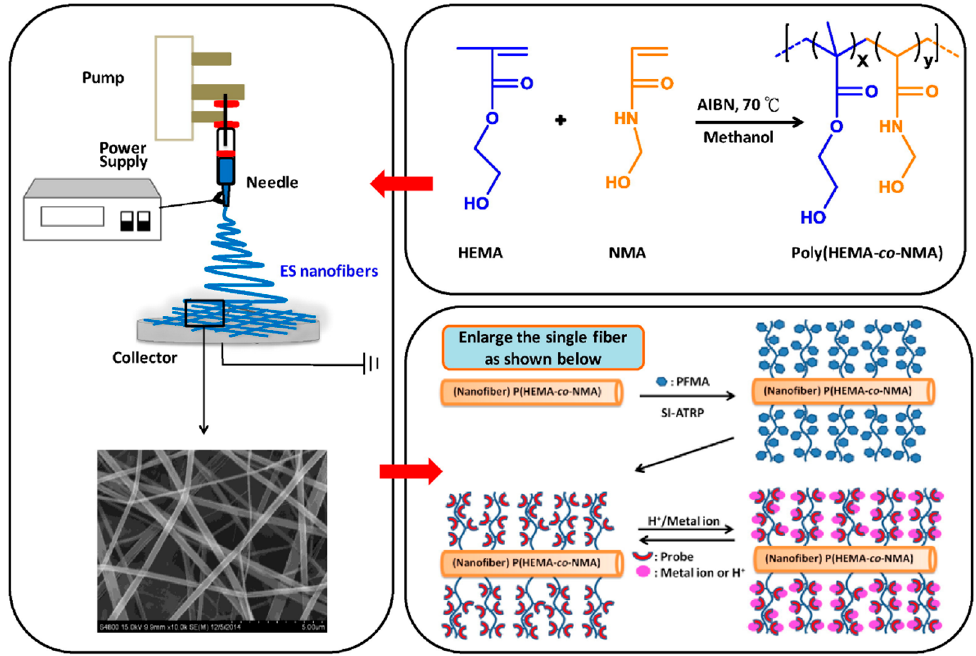
Figure 8. Design of multifunctional fluorescent ES nanofibers from poly(HEMA- co -NMA) ES nanofibers with grafted RhBN2 or SRhBOH. Reprinted with permission from [51]. Copyright 2016, Elsevier.